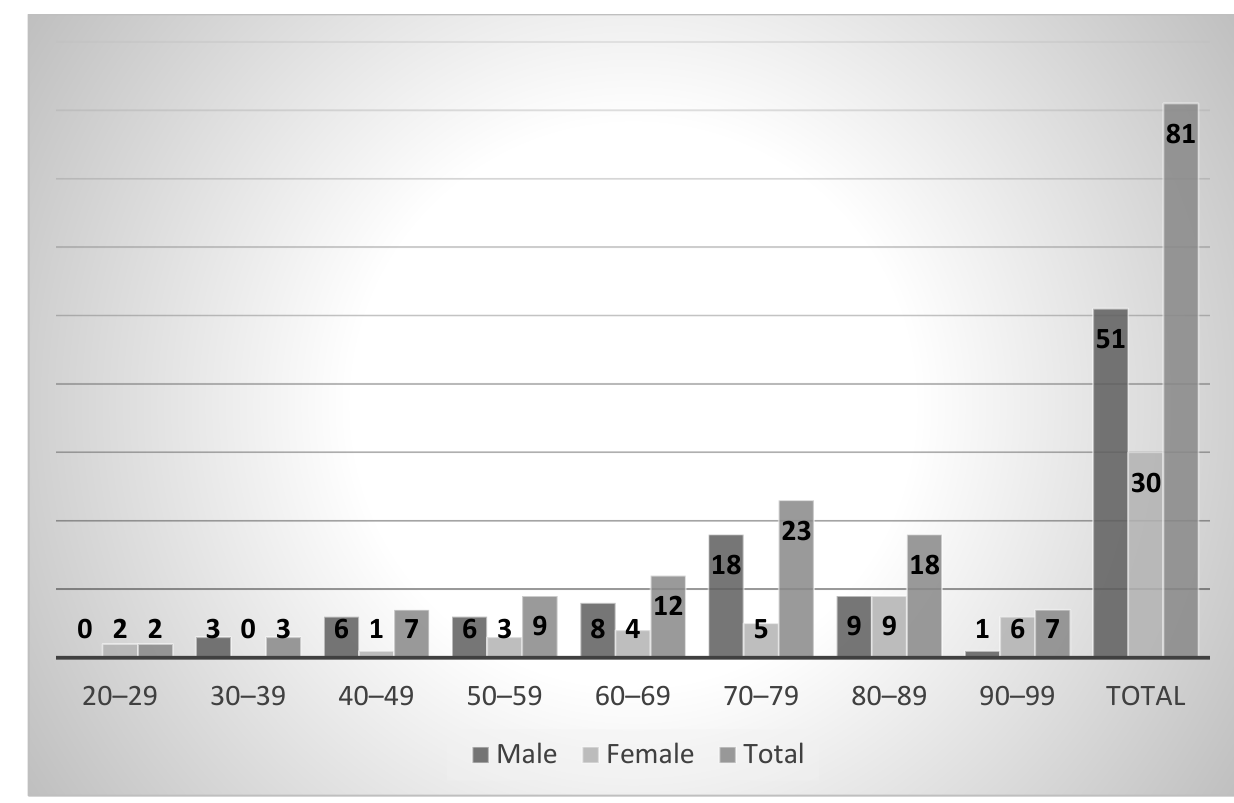
Figure 1. Sex and age distribution of Korean cadavers. ( n = 81).